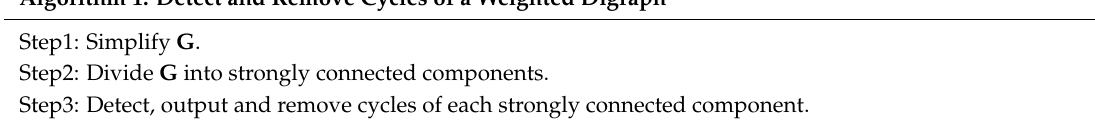
Algorithm 1. Detect and Remove Cycles of a Weighted Digraph